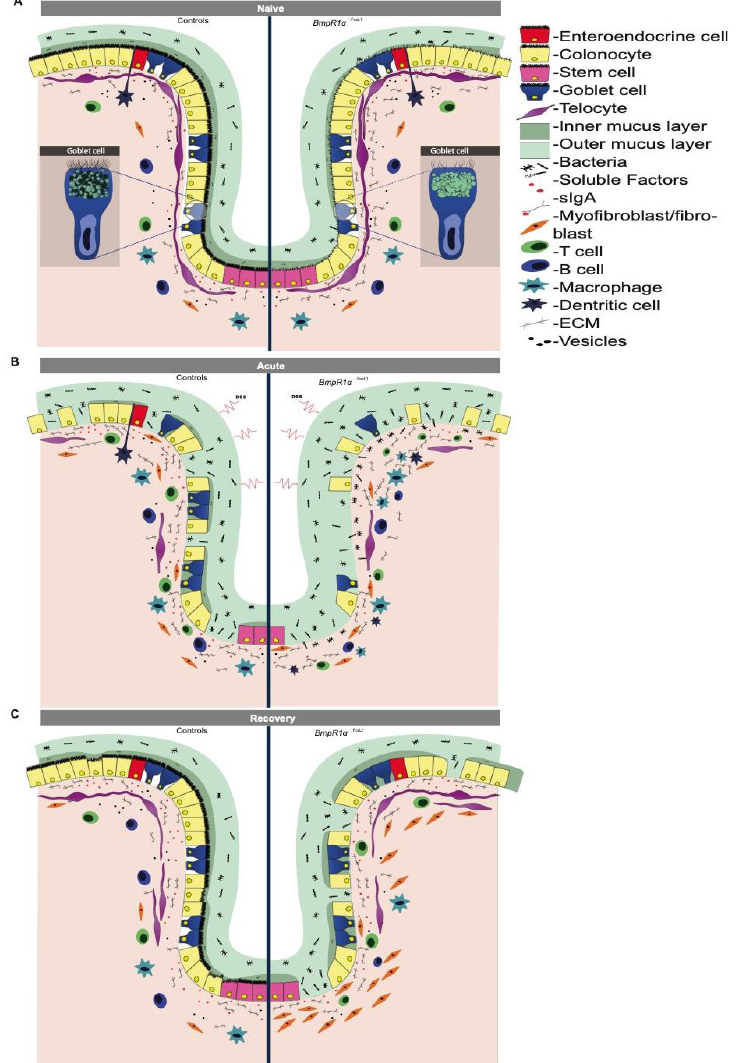
Figure 7. Schematic representation of IBD pathogenesis events in colonic mucosa with impaired BMP-signalling telocytes. ( A ) Under naive condition BmpR1a ∆ FoxL1+ mice showed reduced diversity in goblet cell vesicles, low glycocalyx coating and a thinner and discontinuous barrier layer with bacteria in close contact with the non-inflamed epithelium. BmpR1a ∆ FoxL1+ mice exhibited TC FoxL1+ population with an irregular shape and surrounded by collagen fibers. ( B ) During inflammation, a complete depletion of goblet cells was observed in BmpR1a ∆ FoxL1+ mice and a significant number of bacteria invaded the inflamed colonic mucosa. TC FoxL1+ population was decreased in both groups. A substantial presence of myofibroblasts were found in BmpR1a ∆ FoxL1+ mice compared to controls. ( C ) After the recovery, mucosa in control mice recovered from the insult while in BmpR1a ∆ FoxL1+ mice it presented delayed wound healing. In BmpR1a ∆ FoxL1+ mice, TC FoxL1+ population was found to be displaced along the colonic crypt with more TC FoxL1+ found at the top and less at the bottom. Myofibroblast-like cells (vimentin + ; α SMA + ) were still strongly present in the stroma. Myofibroblast- like cells were found to be scattered in the stroma with a robust presence at the base of the